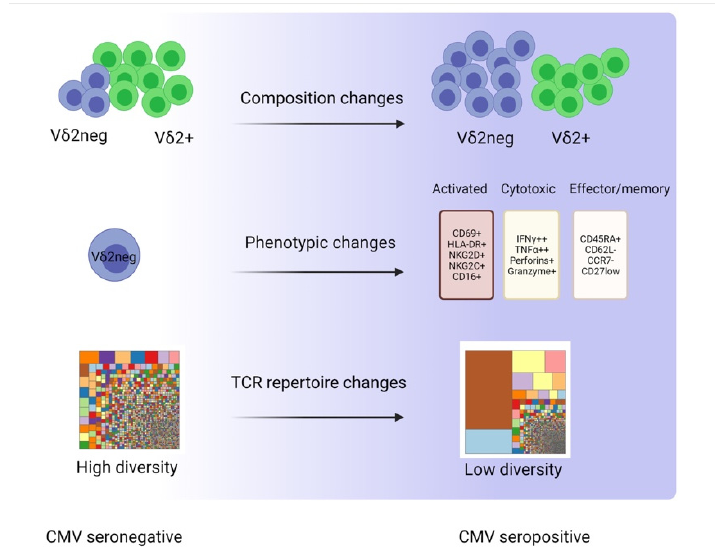
Figure 2. CMV-induced changes in γδ T cells: a representative figure showing the phenotypic, composition, and clonotypic changes in γδ T cells in response to CMV (created with BioRender.com). Table 2. CMV-induced expansion of V δ neg γδ T cells in different transplant settings. Transplant